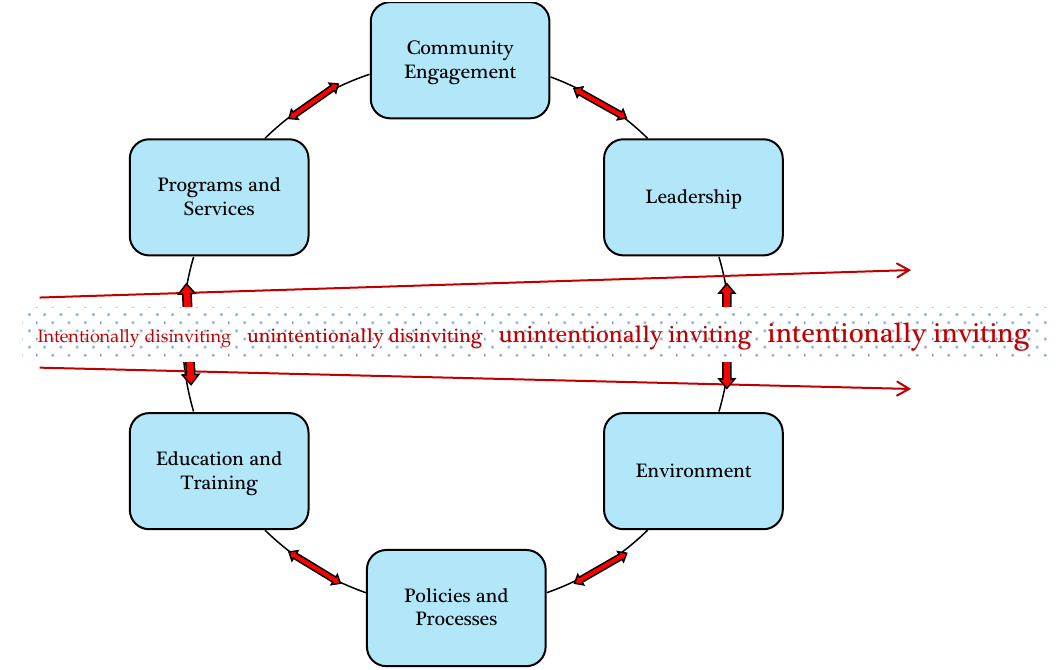
Figure 1. Two-Spirit, lesbian, gay, bisexual, transgender, queer, non-binary, and intersex (2SLGBTQ+) home care access and equity framewor